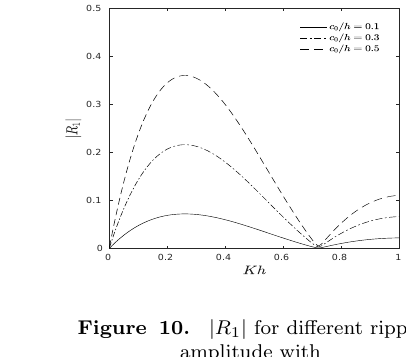
Figure 9. | R 1 | for different ripple number with l 1 /h = 0 . 05 ,l 2 /h = 0 . 2 ,c 0 /h = 0 . 1.